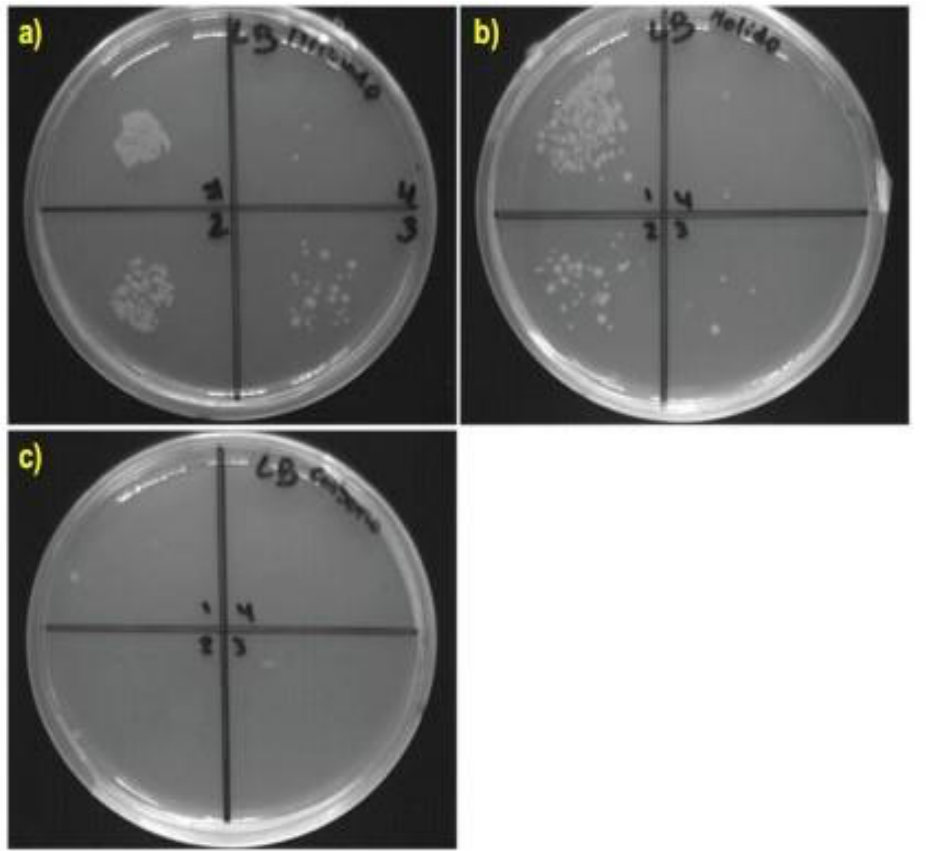
Figure 3. Images showing the colonies of E. coli bacteria left on the surfaces of neat LDPE ( a ), ball-milled LDPE ( b ), and LDPE/MWCNT nanocomposite ( c ). Taken from [53].